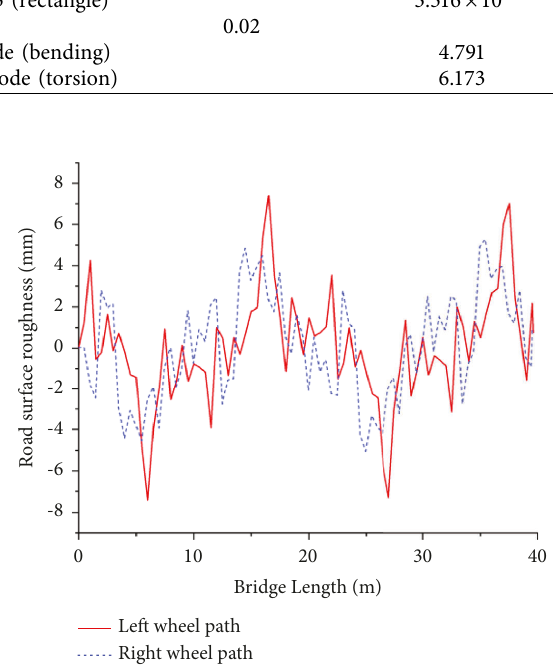
Figure 14: Road surface roughness for left and right wheel